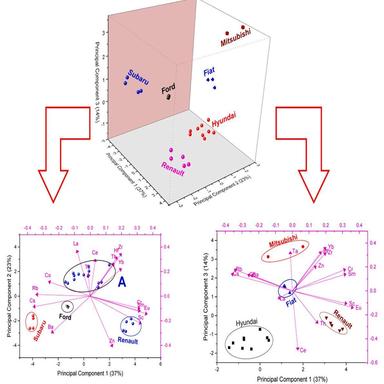
Principal Component Analysis (PCA) utilizing trace elemental concentrations.